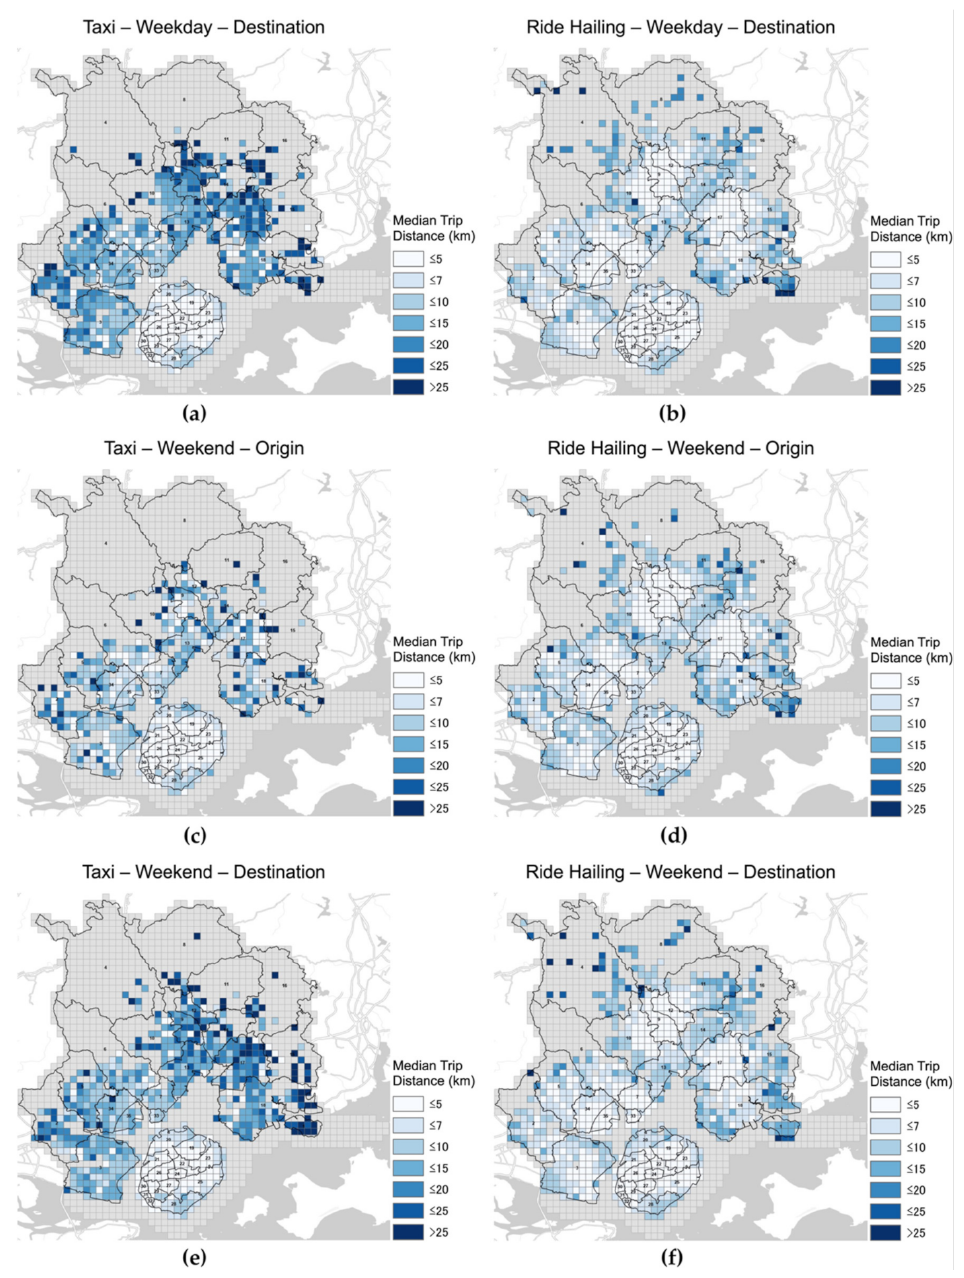
Figure A2. Median trip distances of: ( a , b ) incoming trips of taxiing and ride-hailing on weekdays; ( c , d ) outgoing trips of taxiing and ride-hailing at weekends; and ( e , f ) incoming trips of taxiing and ride-hailing at